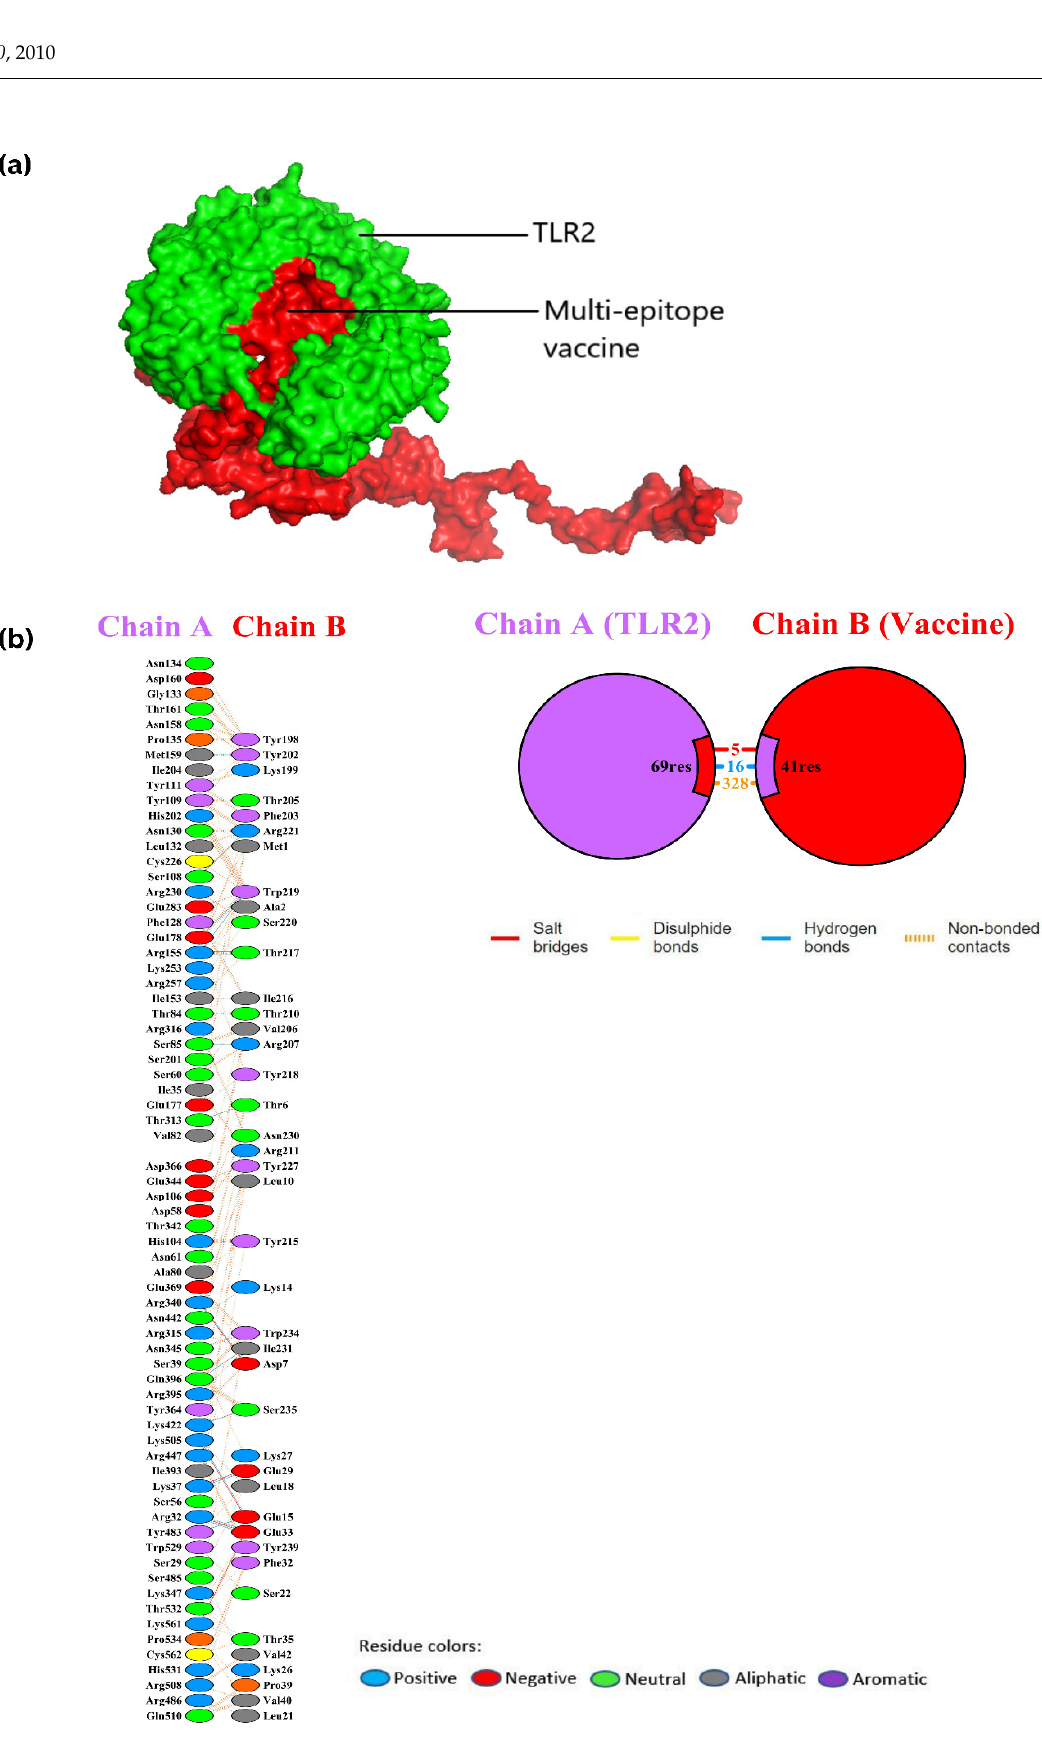
Figure 9. ( a ) Docked complex between TLR2 and multi-epitope vaccine; ( b ) protein–protein inter- action of TLR2–vaccine complex.